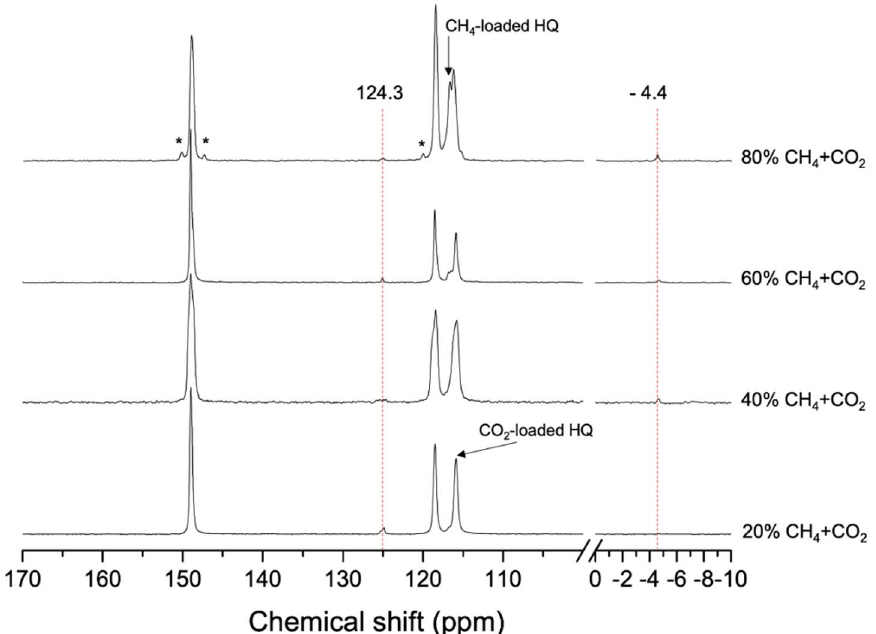
Figure 4. Solid-state 13 C NMR spectra for the HQ samples after reaction with binary (CH 4 + CO 2 ) gas mixtures of various compositions at 20 bar. Two dotted lines at 124.3 and −4.4 ppm indicate the carbon signals from CO 2 and CH 4 in clathrate cages, respectively. Asterisk marks show the unreacted HQ in the α-form.